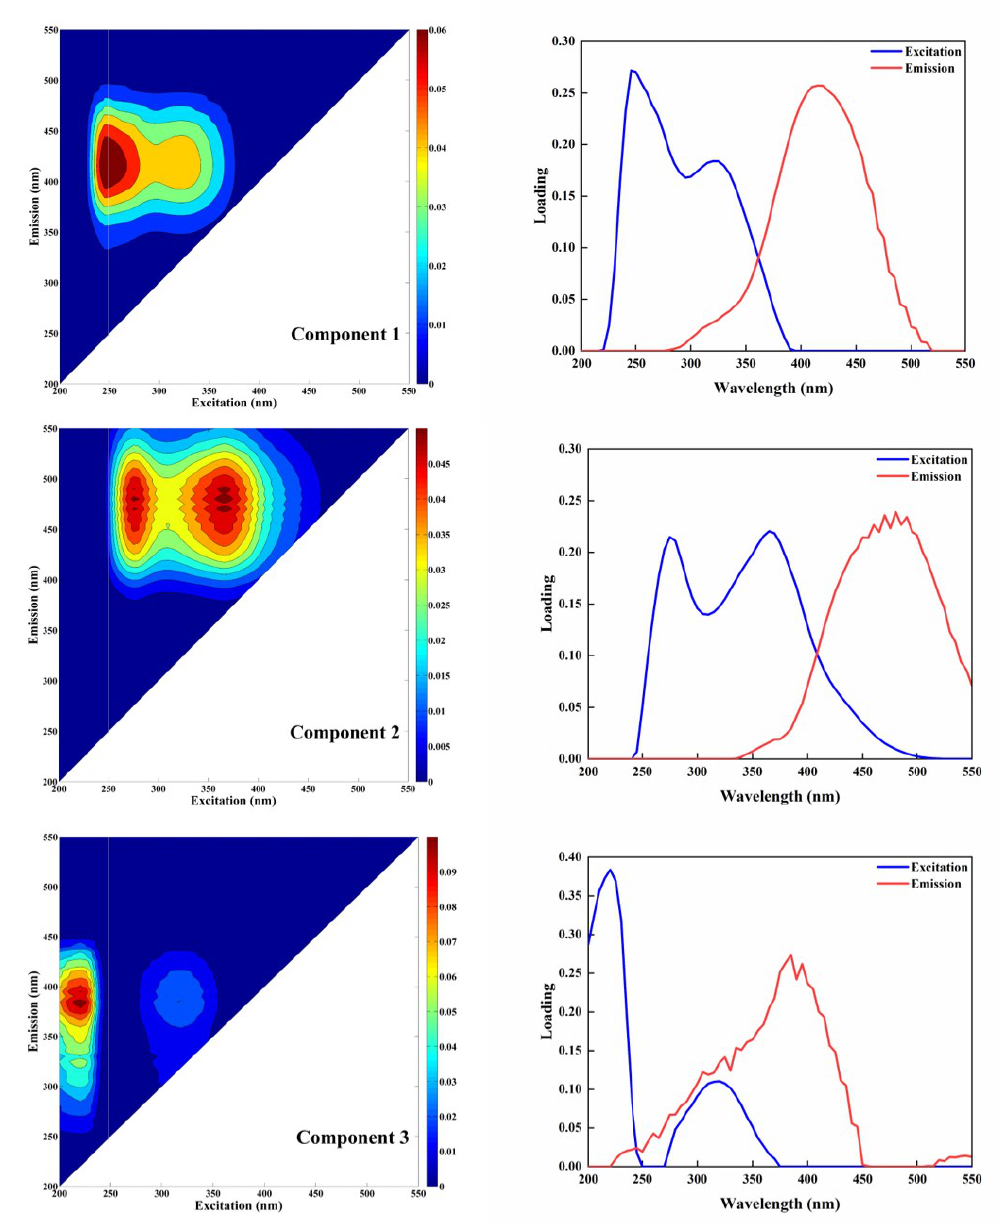
Figure 5. PARAFAC model B. Spectral characteristic EEM images of fluorescent components identi- fied using EEM-PARAFAC analysis of temperate forest soil sample with the addition of